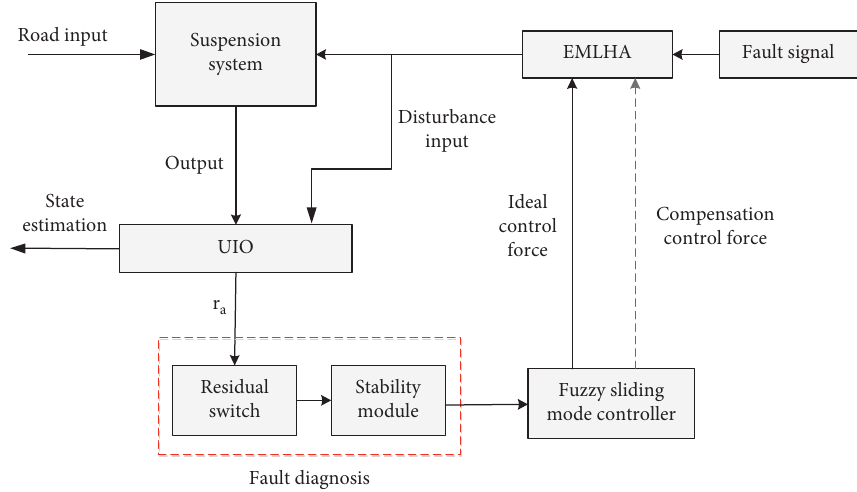
Figure 10: The structure diagram of fault diagnosis and fault-tolerant